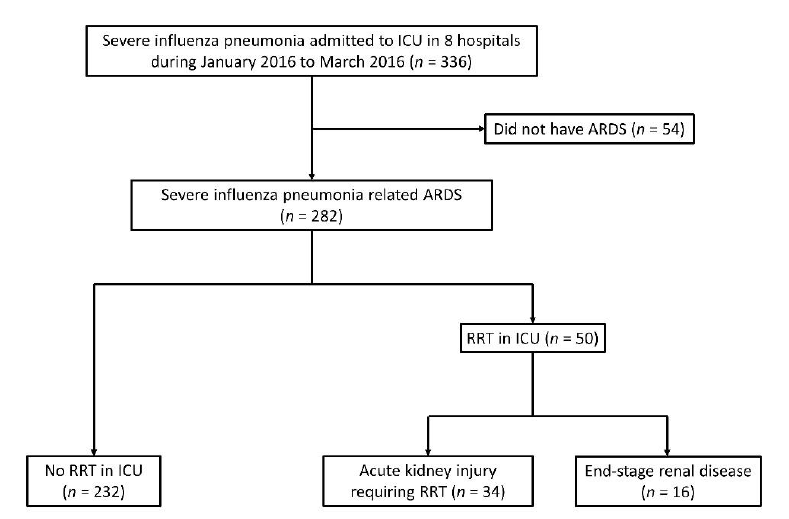
Figure 1. Flow chart of patients in this study; ARDS: acute respiratory distress syndrome; ICU: intensive care unit; RRT: renal replacement therapy.